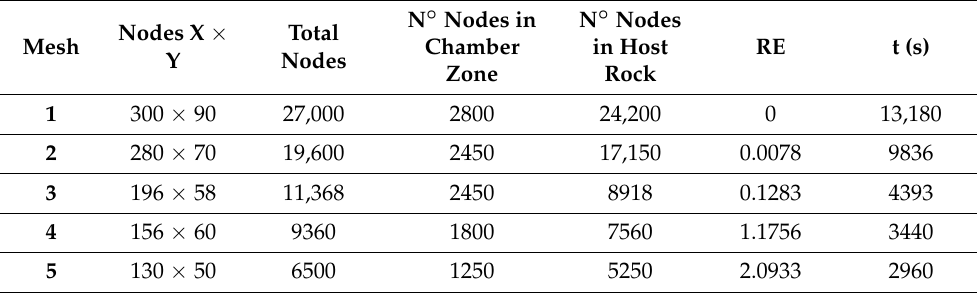
Table 2. Different meshes studied and the relative errors (RE) between V velocity profiles in position V (2.8–5.2; 0.5), compared with the more refined mesh 1.